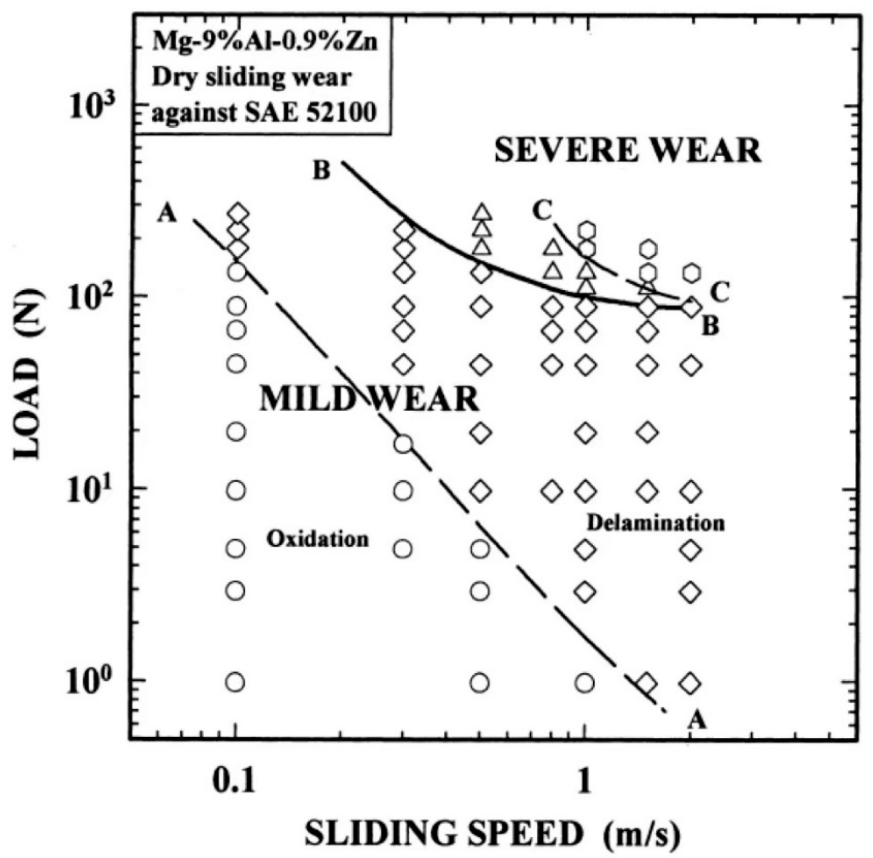
Figure 11. Wear transition map for AZ91 showing the region of dominance of wear mechanisms and the transition boundaries between them; BB: mild wear to severe wear transition; AA: transition between the oxidational wear ( ○ ) and delamination ( ◇ ) wear in the mild wear regime; CC: transi- tion between severe deformation induced wear ( △ ) and melt wear ( ⬡ ) [121]. Reprinted from Wear, 246, Chen, H.; Alpas, A.T., Sliding Wear Map for the Magnesium Alloy Mg-9Al-0.9 Zn (AZ91), 106–116, 2000, with permission from Elsevier.